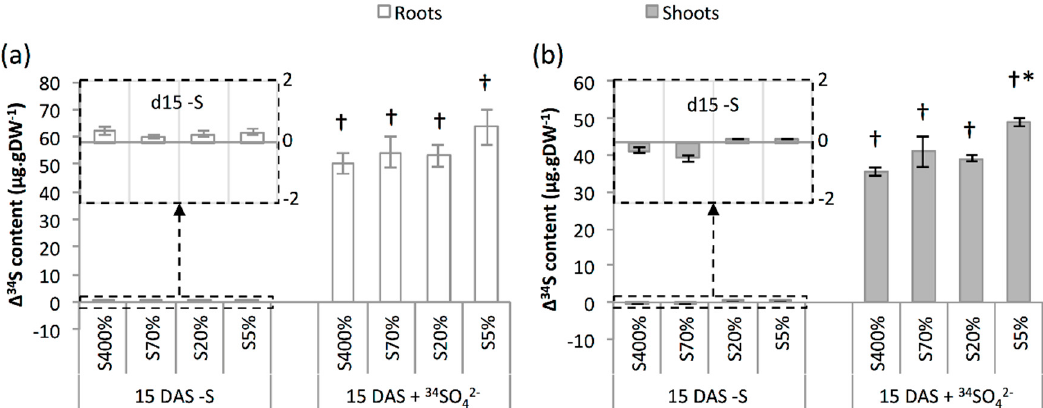
Figure 3. Differences in 34 S ( Δ 34 S) content in excess in roots ( a ) and shoots ( b ) of oilseed rape green seedlings between 14 DAS and 15 DAS-S and between 14 DAS and 15 DAS + 34 SO 42 − . Values correspond to means ± SE (n = 3). Seedlings were grown from seeds harvested on plants subjected to plethoric S nutrition (400% of plant S needs provided, S400% seeds) or subjected to a S limitation from the beginning of plant growth with 70%, 20% and 5% of plant S needs provided (S70%, S20% and S5% seeds, respectively). † Significant difference from the 15 DAS-S value ( p < 0.05). * Significant difference from the corresponding value of S400% seedlings ( p < 0.05).